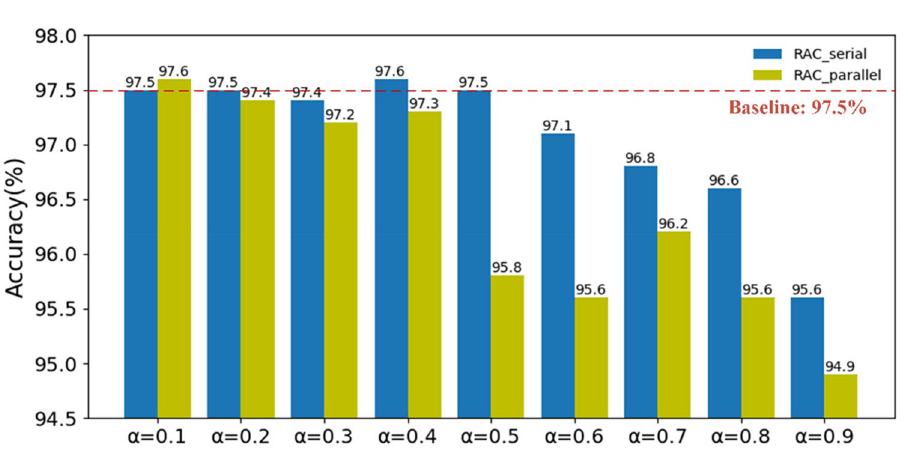
Figure 9. The performance of RAC module under different